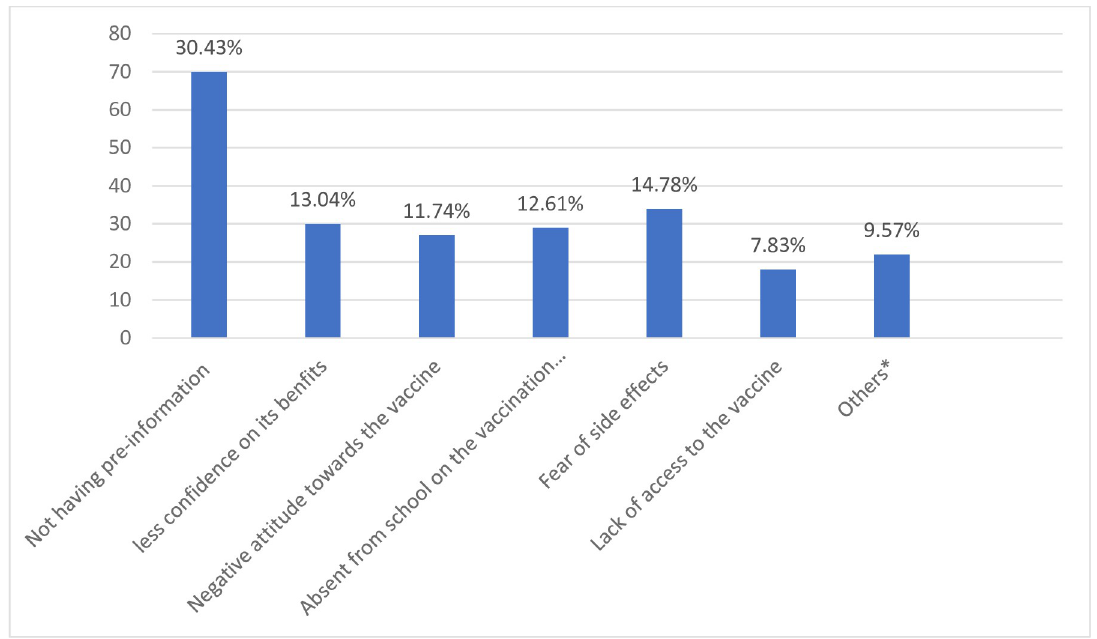
Fig 3. Reasons for not considering to get vaccinated among adolescent school girls in Ambo town, central Ethiopia, 2020 (n = 230). � Parental Influence, peer influence, social pressure.